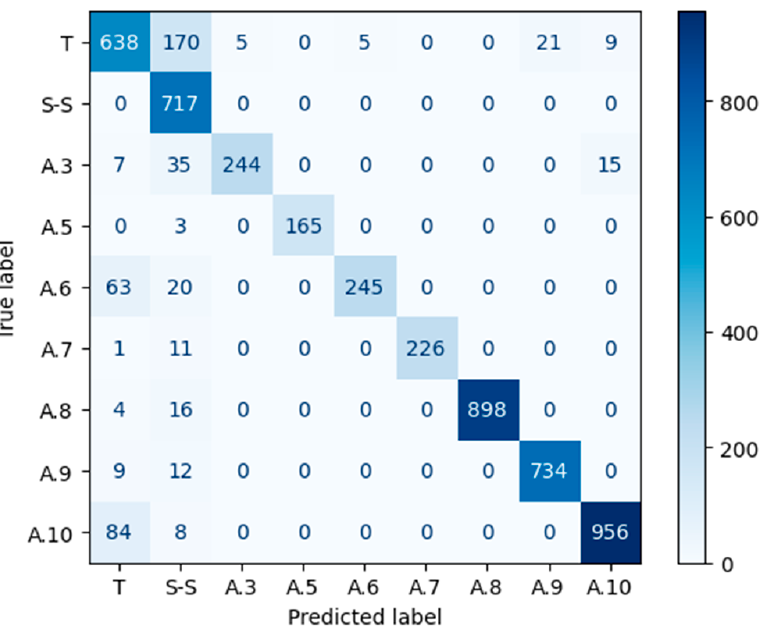
Figure 13. Input data confusion matrix.